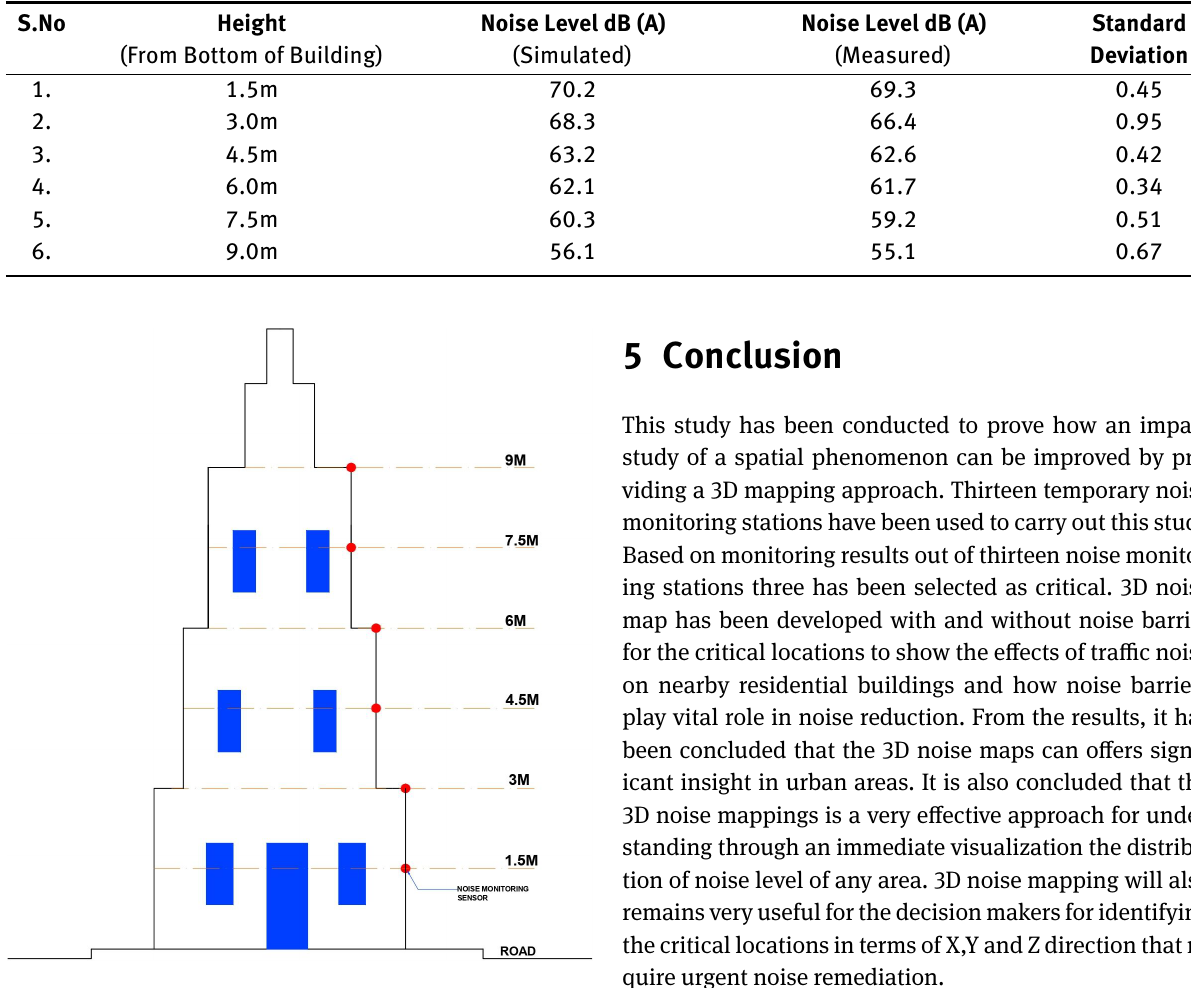
Figure 14: Location of noise monitoring sensors for validation of 3D noise